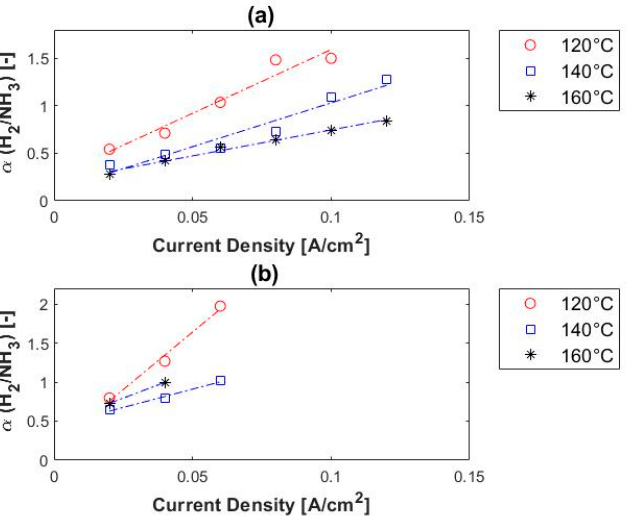
Figure 5. H 2 /NH 3 selectivity for: ( a ) 1500 ppm and ( b ) 3000 ppm NH 3 (balance hydrogen) [188].